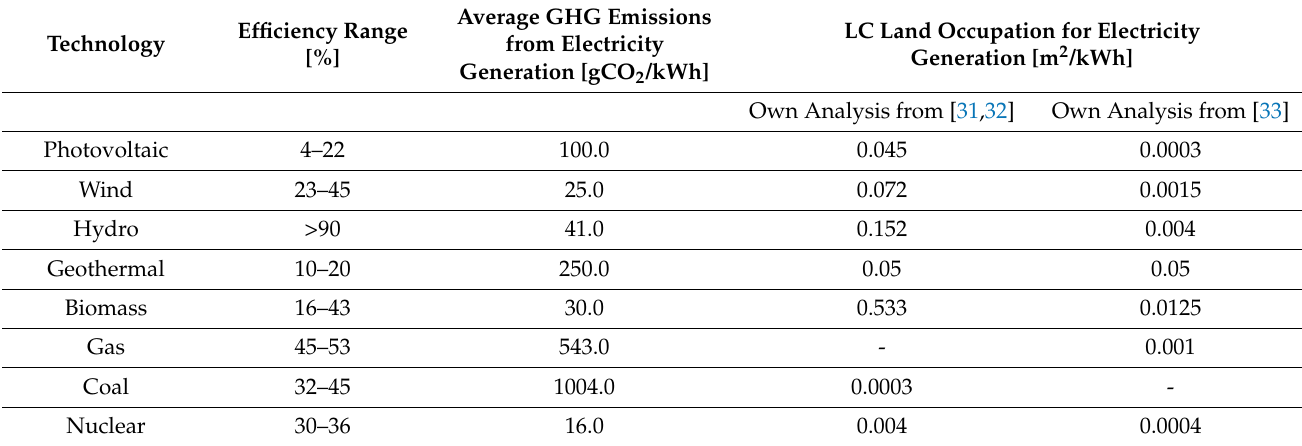
Table 13. Electrical efficiencies of electricity generation, average GHG emissions from electricity generation (own analysis from [28–30]), LC land occupation for electricity generation (own analysis from [31–33]).